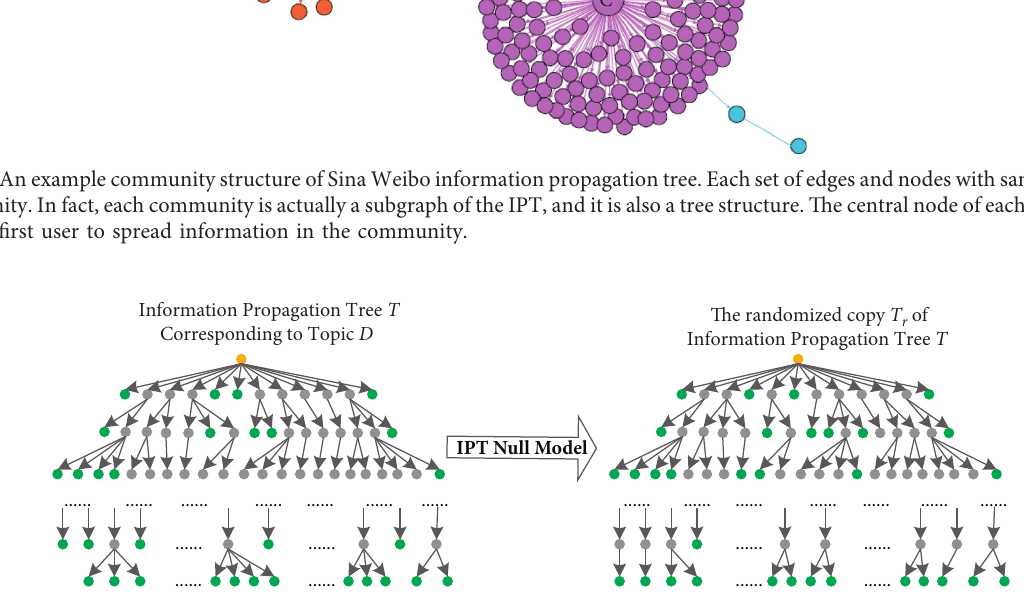
Figure 6: The general procedure of the IPTnull model for different topics of information propagation. The left is the original IPT, and the right is the corresponding randomized copy of the IPT. The core of the edge rewiring strategy is to keep the nodes of each layer of the IPT unchanged, and then, the upper node of the two adjacent layers selects a node from the lower layer according to the probability shown in equation (3) and then establishes a directed